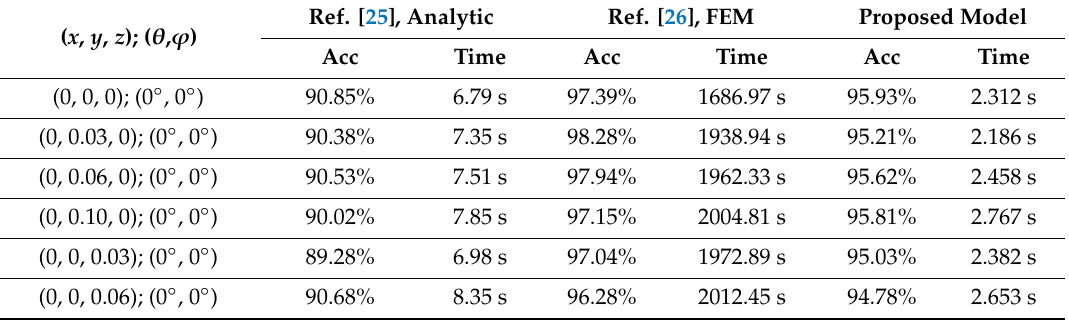
Table 2. Accuracy (first row) and computation time (second row) of mutual inductance under various positional and directional misalignments by analytic method, FEM (finite element method), and the proposed model.